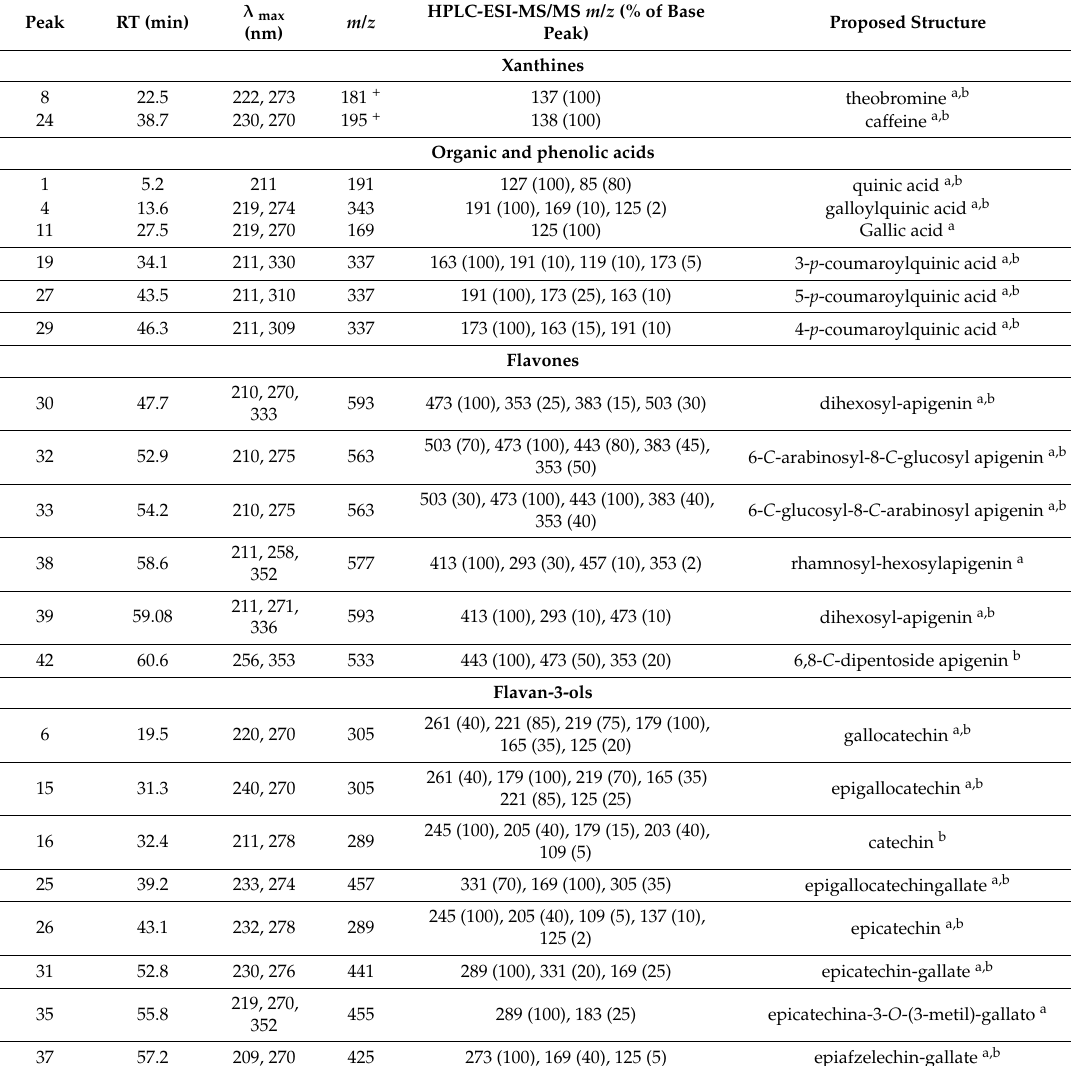
behavior, UV-Vis, MS and MS n spectra, Table 2) with that available in the literature. Figure 1 shows, as an example, a OGABA chromatogram, acquired as total scan PDA. Table 2. Chromatographic behavior (retention time, RT), UV, MS and MS/MS data of the compounds identified in GGABA and OGABA